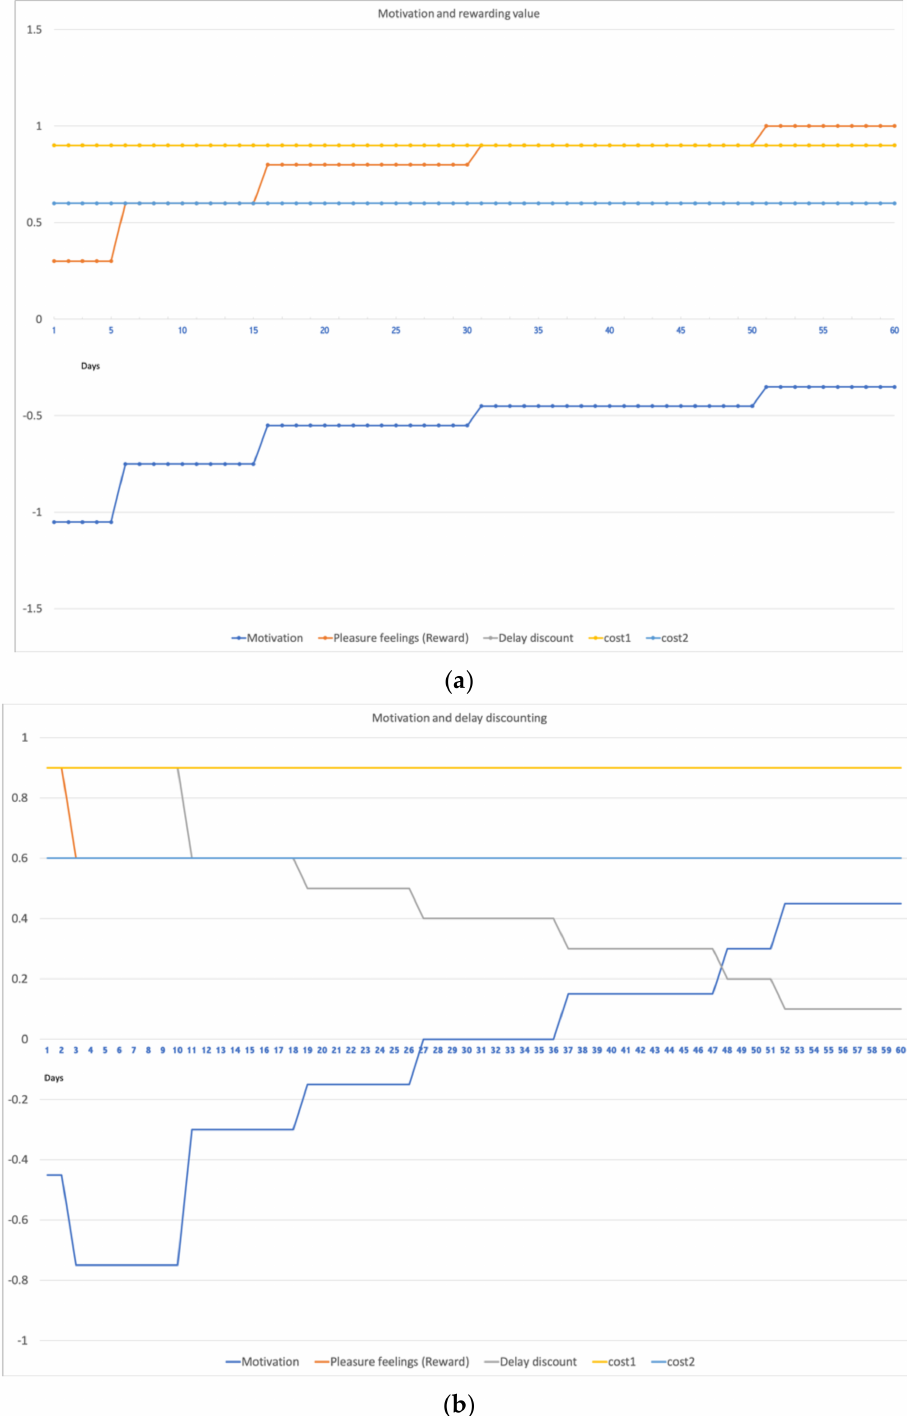
Figure 3. Motivation concerning different model parameters/processes through different